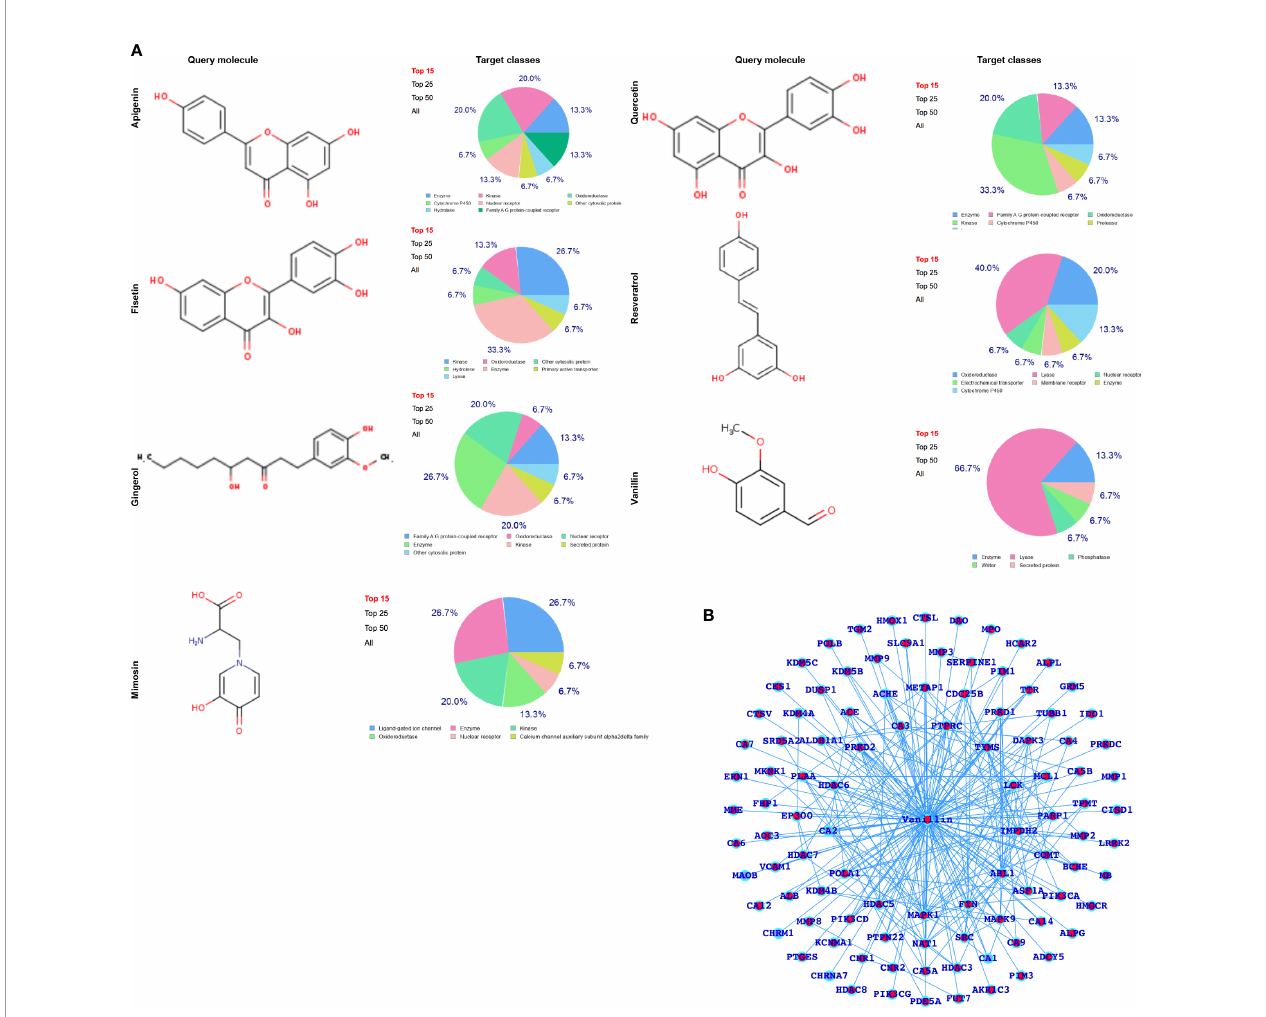
FIGURE 2 | (A) Selected herbal drugs and their potential proteins interact with the respective drugs. Here, the pie chart represents the classes of the proteins. (B) Vanillin-associated